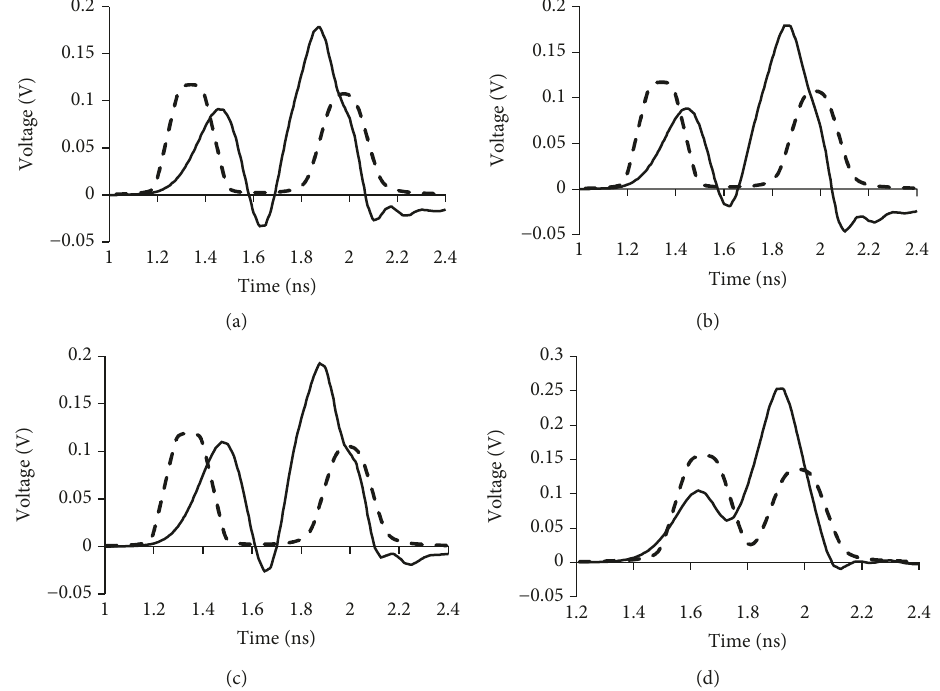
Figure 6: Voltage waveforms at the output of the MF with passive conductors: (a) solid, (b) hollow, (c) corner, and (d) thin, obtained by (- -) lossy simulation and (––)